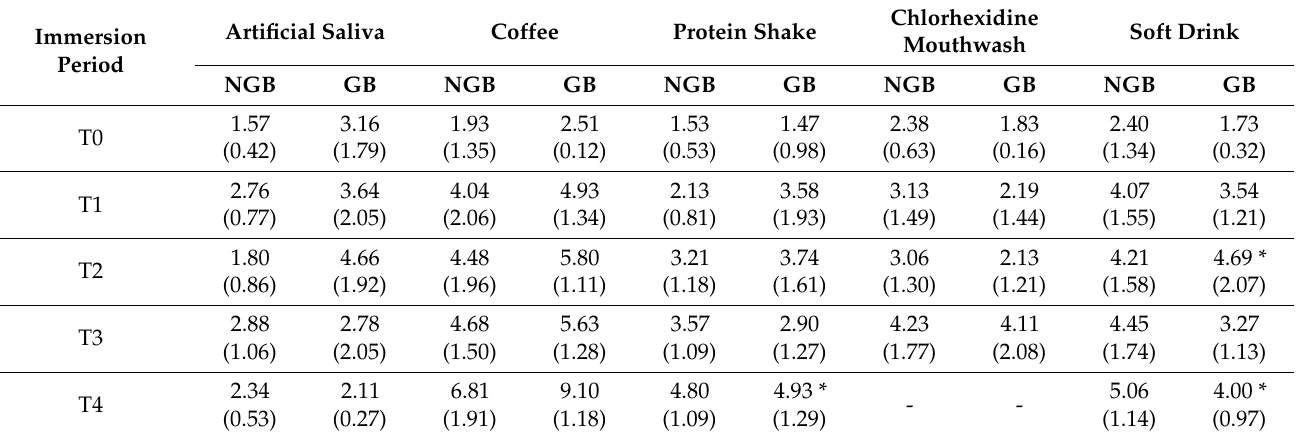
Table 6. ∆ E of extra translucent zirconia in different mediums at different times; values are expressed as mean (SD).